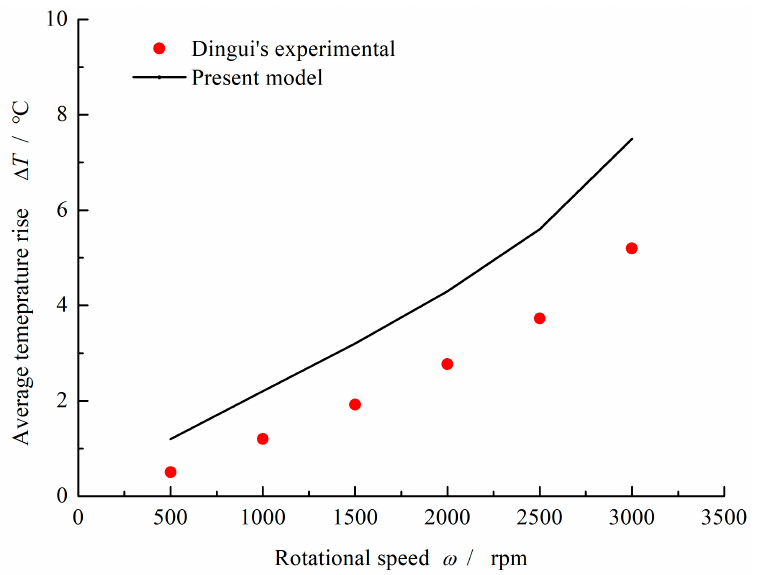
Figure 4. Comparison of numerical results and experimental results. ( p o = 0.6 MPa, p i = 0.1